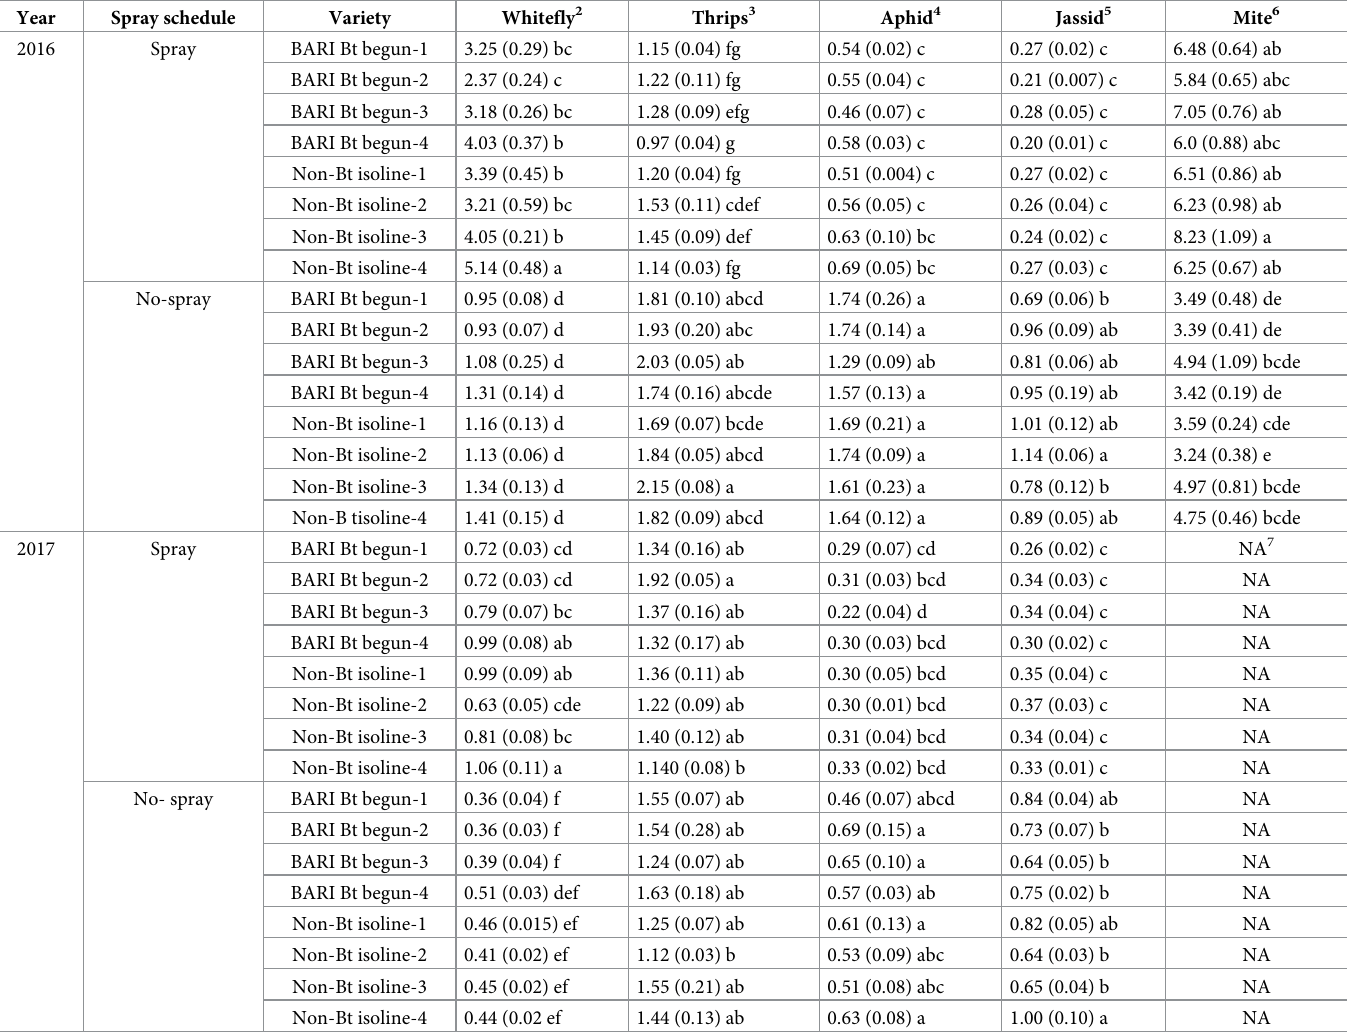
Table 3. Mean abundance 1 of non-target pest arthropods (No./leaf) in brinjal relative to insecticides and varieties, OFRD, BARI, Bogra,